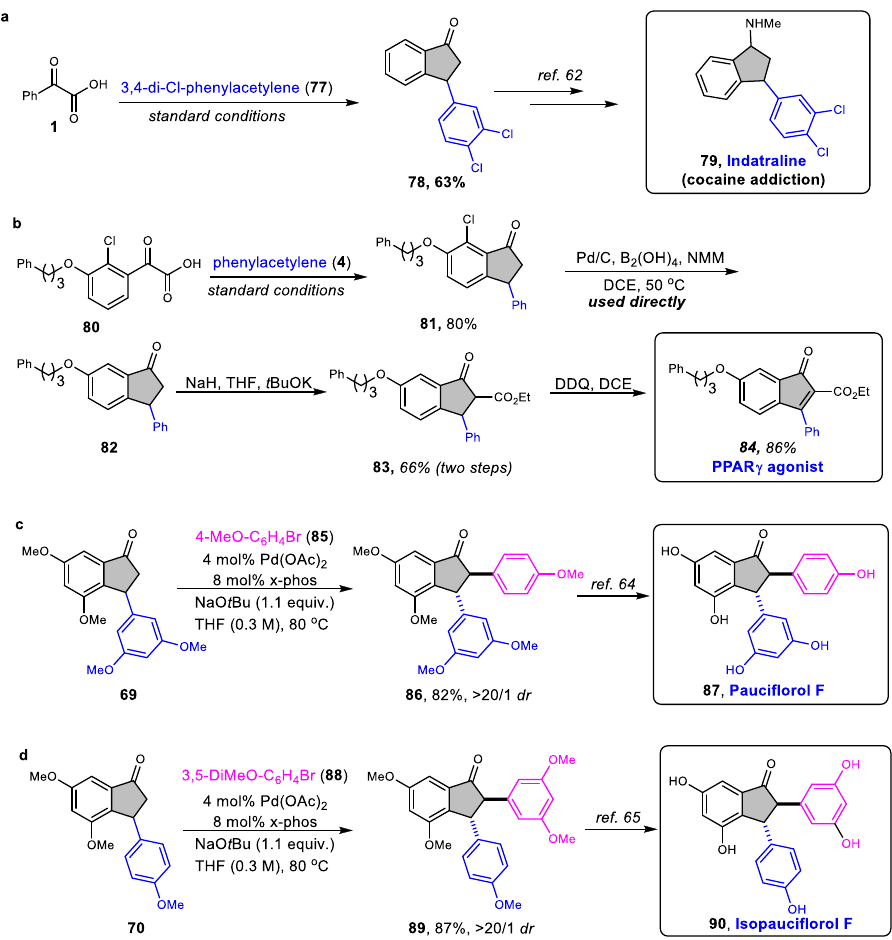
Fig. 5 Synthetic applications of indanones. a Key intermediate for indatraline construction could be afforded by the developed protocol. b Synthesis of PPAR γ agonist using this strategy. NMM 4-methylmorpholine. c Powerful protocol to prepare pauci fl orol F. d Formal synthesis Isopauci fl orol